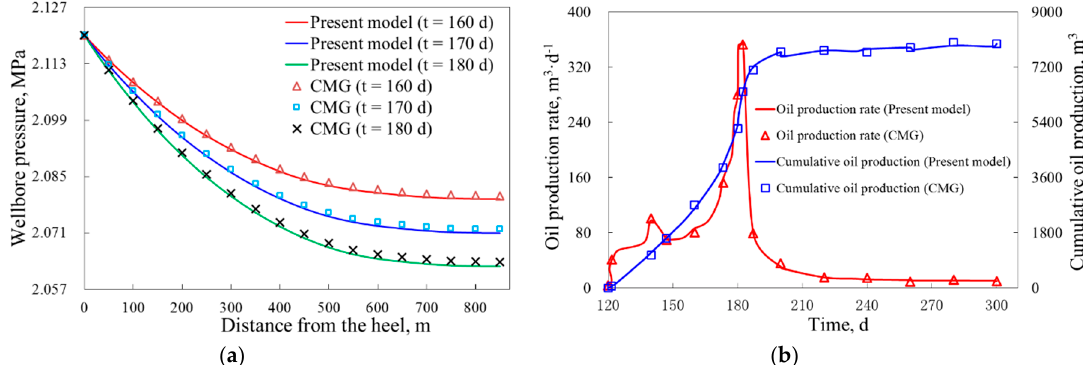
Figure 8. Comparison of the predicted results with CMG in the SAGD operation: ( a ) injector wellbore pressure; ( b ) oil production rate and cumulative oil production.